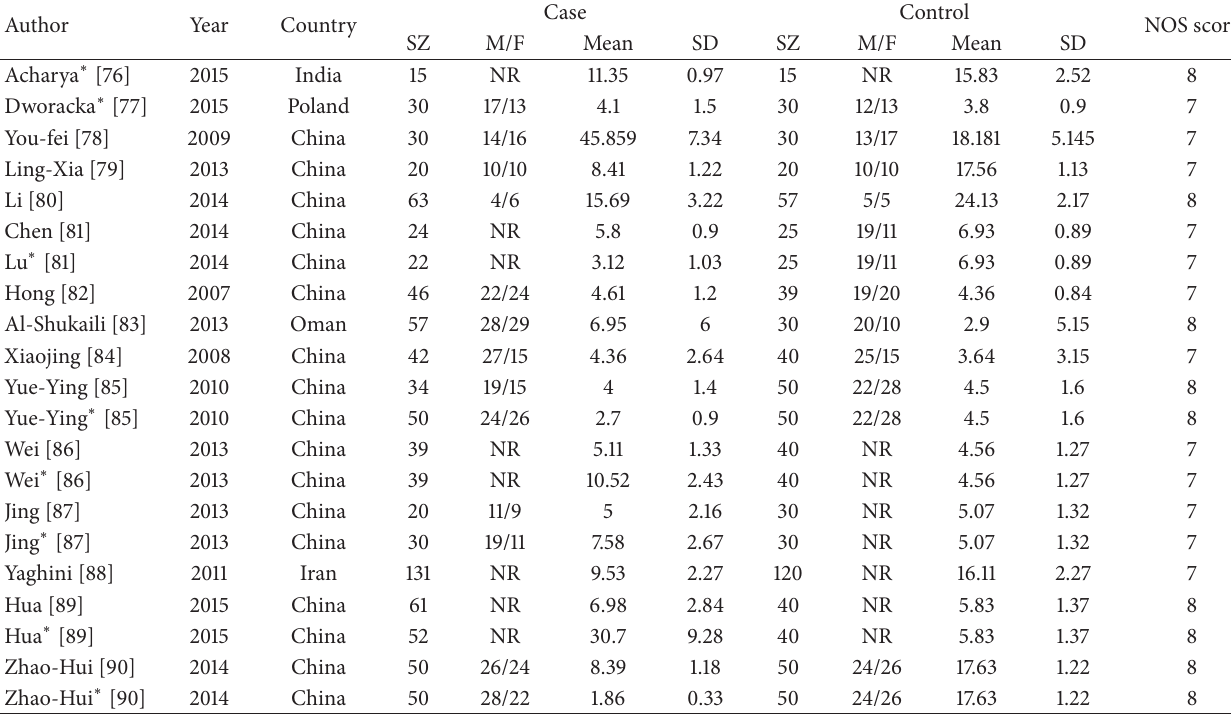
Table 5: Characteristics of studies about IL-10 (pg/mL) included in this